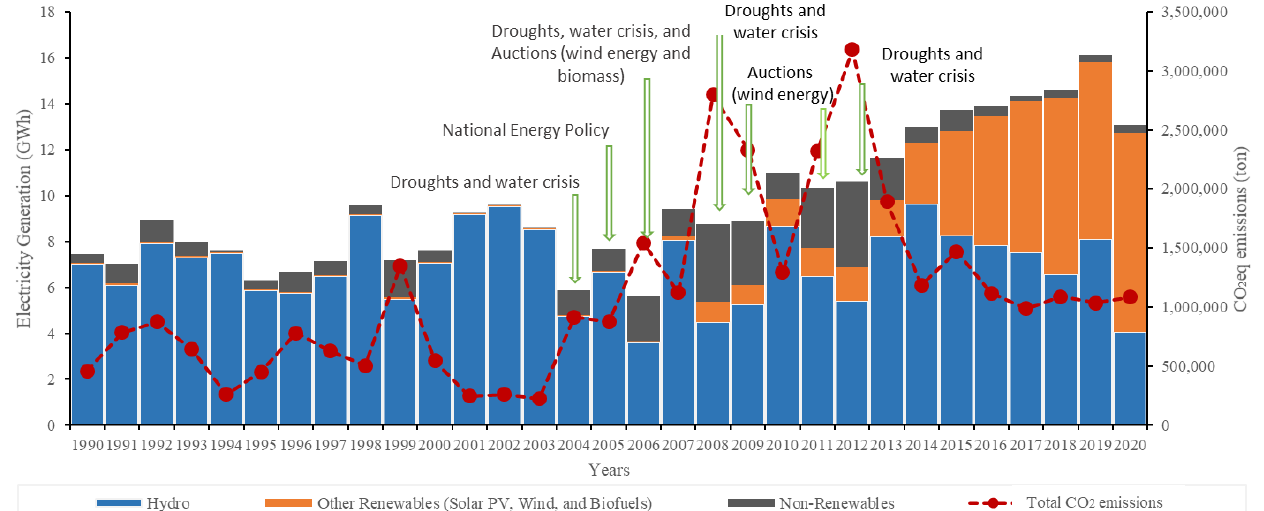
Figure 5. Uruguay’s electricity generation from renewable (colored scale bars) and non-renewable (grayscale bars) sources and the total CO 2 eq emissions. Source: Elaborated by the authors based on [38–40].